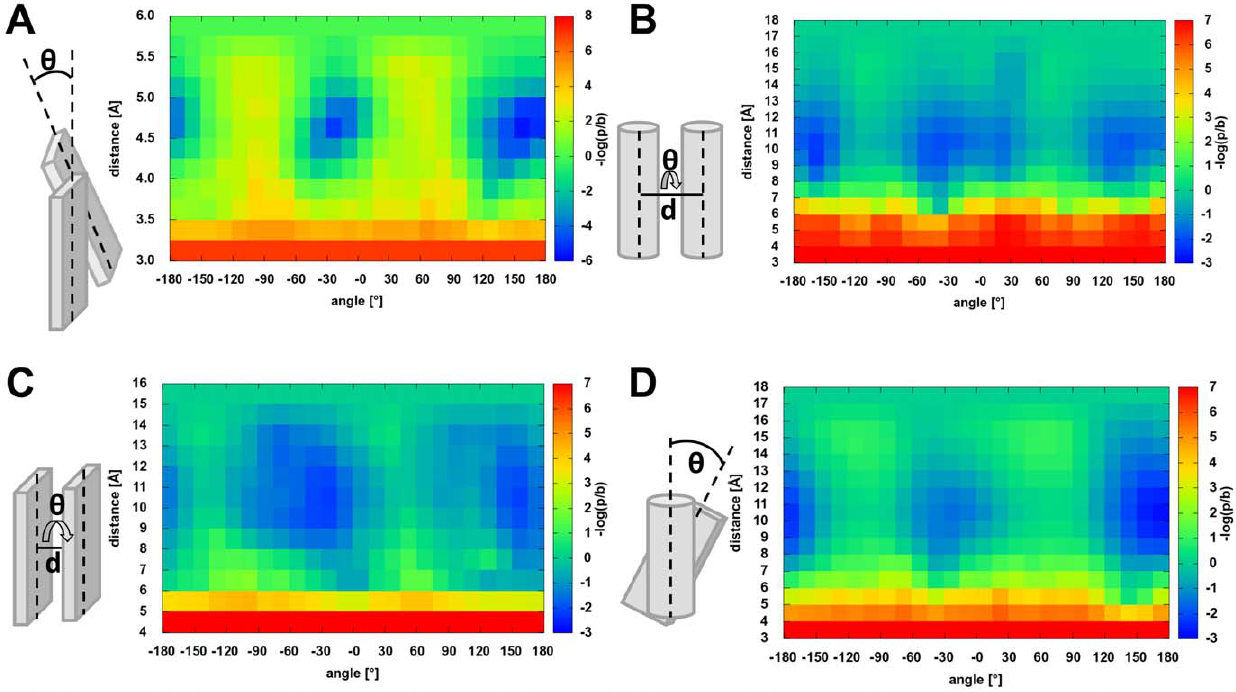
Figure 5. Strand pairing and SSE packing potential. Shown are all secondary structure element packing potentials with their schematic shortest connections, twist angle and their derived potentials. A shows the b -Strand- b -Strand pairing potential with prominent distance of 4.75 A˚ and angles of 2 15 u and 165 u . B shows the a -Helix- a -Helix packing with preferred packing distance of 10 A˚ and the preferred parallel angle of 2 45 u and the anti-parallel packing of 135 u . C shows the b -Sheet- b -Sheet packing potential with a preferred distance 10 A˚ and angles of 2 30 u and 150 u . D shows the a -Helix- b -Sheet packing with its packing distance around 10 A˚ and an anti-parallel angle of 150 u –180 u .